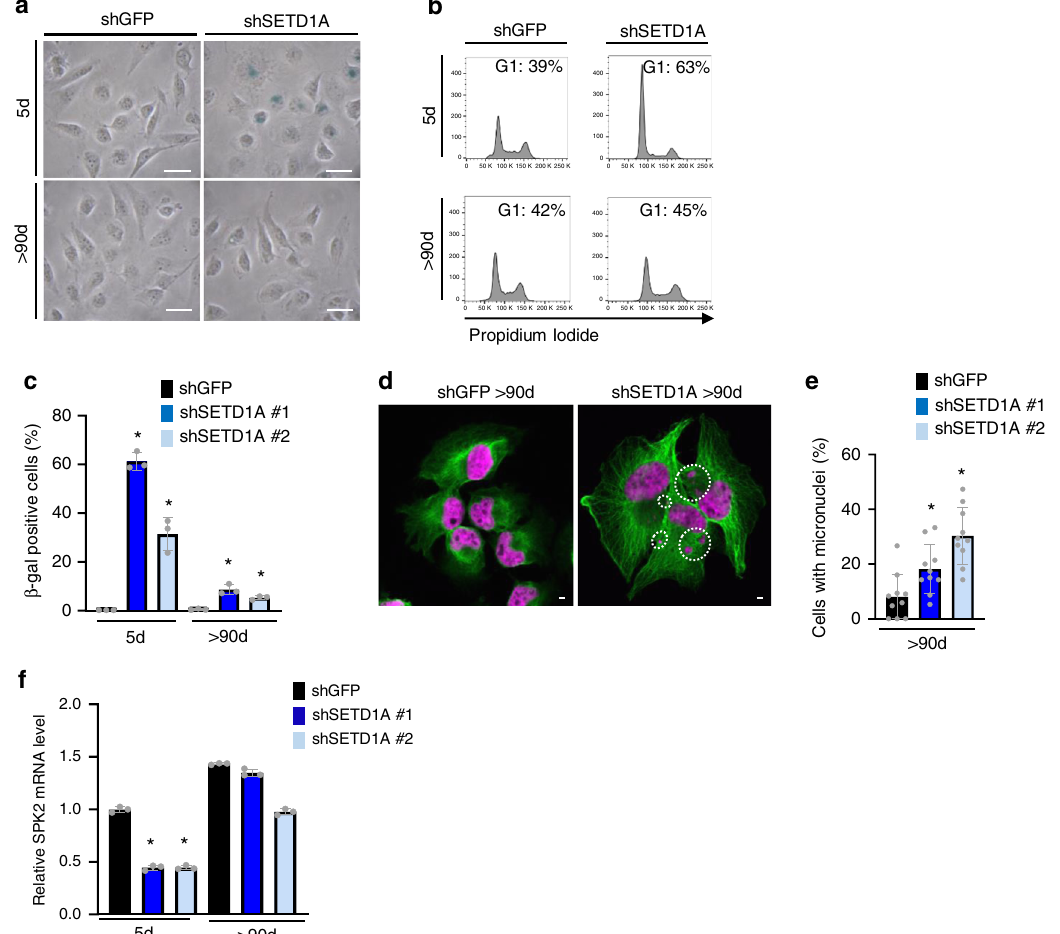
Fig. 6 SETD1A-KD cells escape senescence after prolonged culture. a SETD1A-KD cells maintained in culture for over 90 days show reduction in the fraction of ß-gal positive cells. Images of ß-gal stained control (shGFP) and SETD1A-KD MDA-MB-231 cells that are senescent (5 days after SETD1A-KD) or escape senescence after prolonged culture ( > 90 days) are shown. The scale bar represents 50 µ m. Source data are provided as a Source Data fi le. b Cell cycle analysis of SETD1A-KD cells after 5 days (senescence) or after being maintained for > 90 days in culture (senescence-escape). Escape cells show re-entry into the cell cycle compared with the G1 cell cycle arrest exhibited by SETD1A-KD senescent cells. The quanti fi cation of cells in each stage of the cell cycle in the SETD1A-KD senescent and escape cultures is shown in Supplementary Fig. 6b. c Bar graph shows the percentage of ß – gal positive cells (Mean + SD) following 5 days (senescence) or > 90 days (Escape) of SETD1A-KD. shGFP-tranduced cells are shown as control for both conditions. Data from two independent experiments are presented as Mean + SD; * p < 0.05 by two-tailed unpaired Student ’ s t test. Source data are provided as a Source Data fi le. d Confocal images of cells stained with tubulin (green) and DAPI (magenta) show that SETD1A-KD cells escaping senescence harbor chromosome segregation defects visualized as micronuclei (circled). The scale bar represents 50 µ m. Source data are provided as a Source Data fi le. e Quanti fi cation of SETD1A-KD cells with micronuclei (Mean + SD) under the senescence-escape condition is shown below. shGFP is shown for control. Data from ten different fi elds per sample are presented as Mean + SD; * p < 0.05 by two-tailed unpaired Student ’ s t test. Source data are provided as a Source Data fi le. f SKP2 mRNA expression is restored in SETD1A-KD cells escaping senescence. Bar graph shows quanti fi cation of SKP2 mRNA in cells following 5 days (senescence) and 90 days (Escape) of SETD1A-KD. SKP2 expression in shGFP-transduced cells is shown as control. Data from three independent experiments are presented as Mean + SD; * p < 0.05 by two-tailed unpaired Student ’ s t test. Source data are provided as a Source Data fi